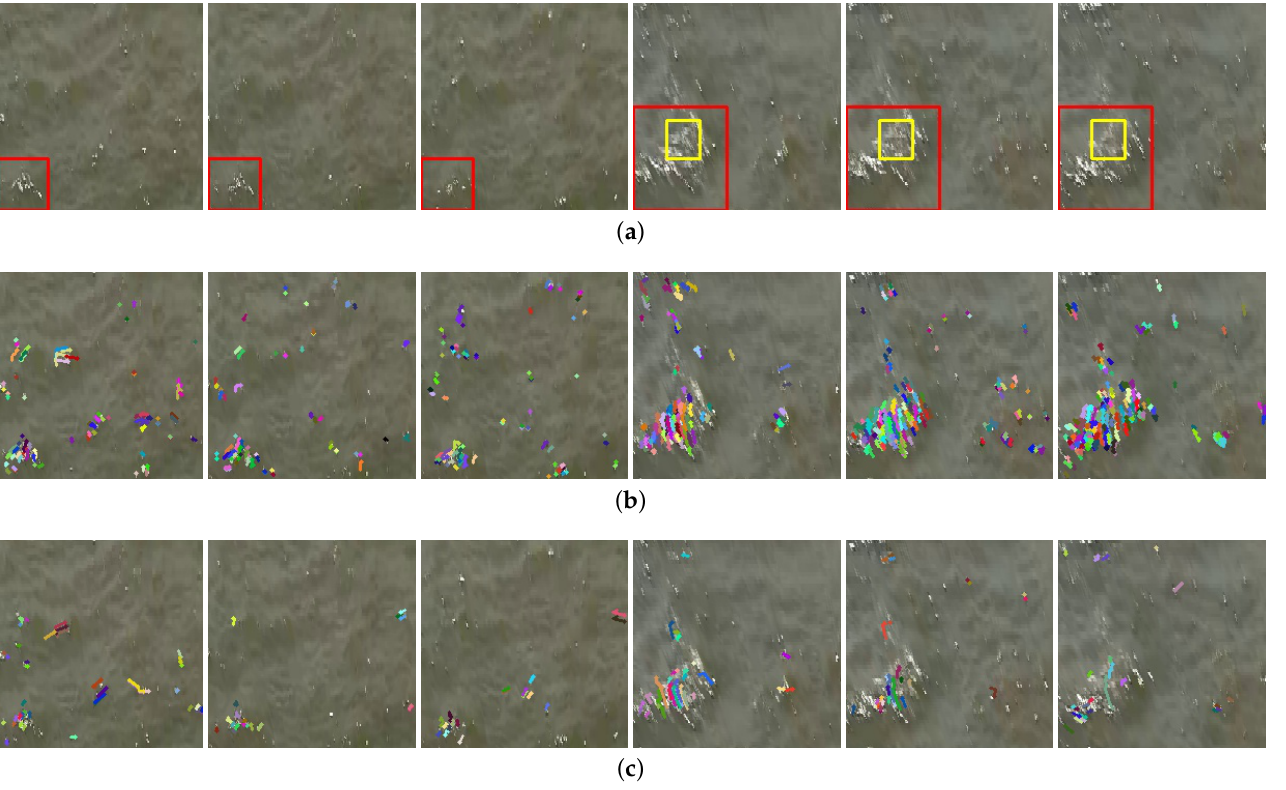
Figure 13. ( a ) Original images for two videos. Three images were taken from each video. ∆ t = 0.16 s; ( b ) T h ; and ( c ) T l